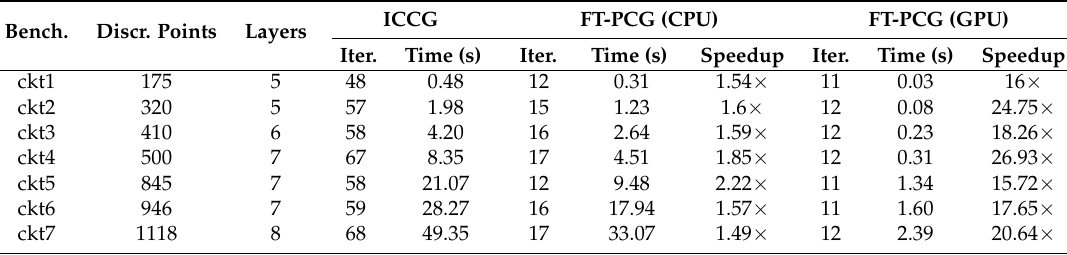
Table 2. Runtime results for the three solvers. Bench. is the name of the benchmark, Discr. Point. is the number of points that correspond to the x and y axis, Layers is the number of layers of each chip and corresponds to the z axis, Time (s) denotes the average time required for the solution at each iteration, Iter. is the average number of iterations required for the convergence of each iterative method, while Speedup denotes the speedup of our method over the